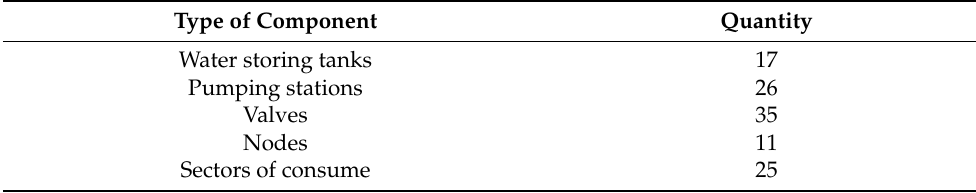
Table 1. Components of the aggregate